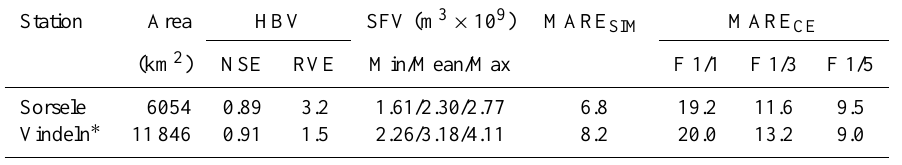
Table 1. Basin and station characteristics including overall performance of the HBV model. MARE (%) of SFV estimated by simula- tion (SIM) and by climatological ensemble (CE) forecasts (F) with different issue dates (1/1, 1/3, 1/5). All values represent 2000–2010.